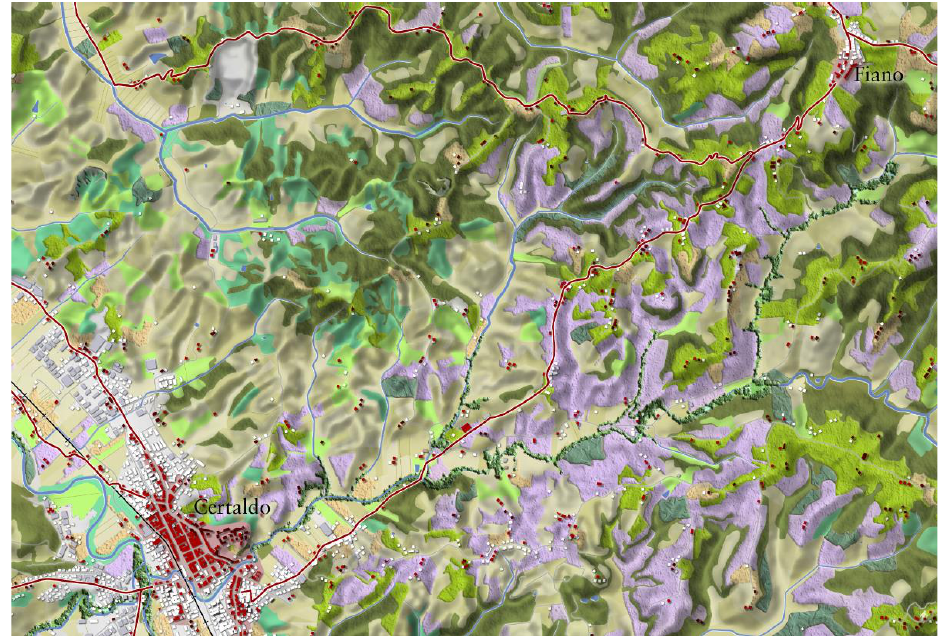
Figure 2. Landscape Plan of Tuscany, landscape characteristics map (a detail for the upper Val d’Elsa).